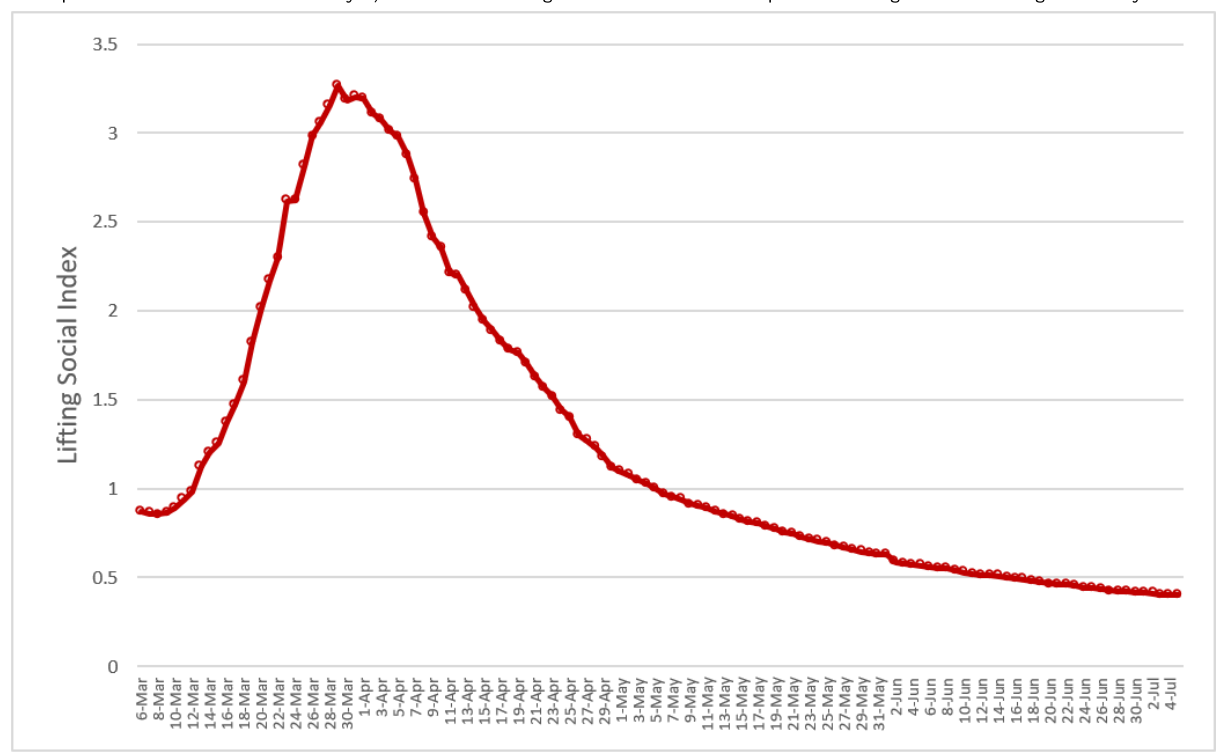
Figure 3. Temporal trend of global lifting social distancing (LSD) index up to July 5, 2020. A total of 120 countries with LSD<1 on June 28 in the pandemic phase. Between March 13 and May 6, the LSD index was greater than 1. The time required for lifting social distancing was 55 days on average.